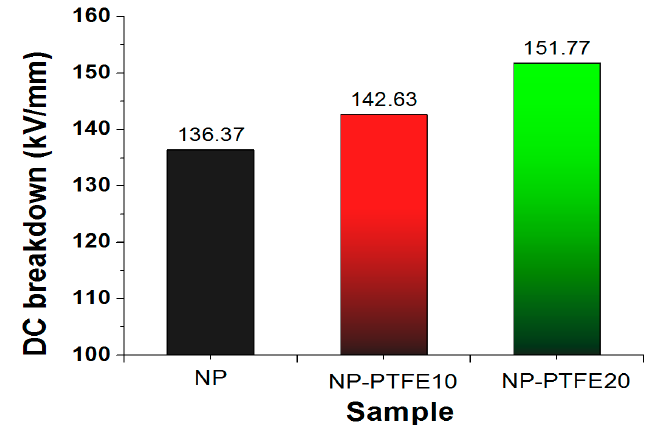
Figure 10. DC pre-pressure breakdown strength of the new pressboard, new pressboard deposited. PTFE for 10 min and 20 min.